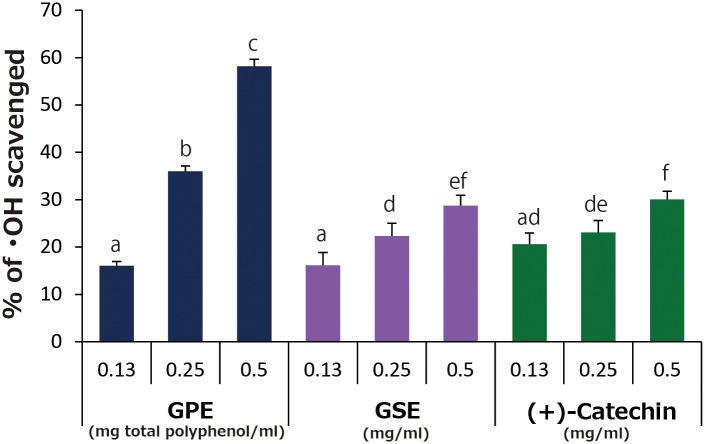
Scavenging activity of GPE, GSE, and (+)-catechin against •OH generated by a Fenton reaction.Each value represents the mean with standard deviation (n = 3). Significant differences (p<0.05) in each group are denoted by different alphabetical letters.